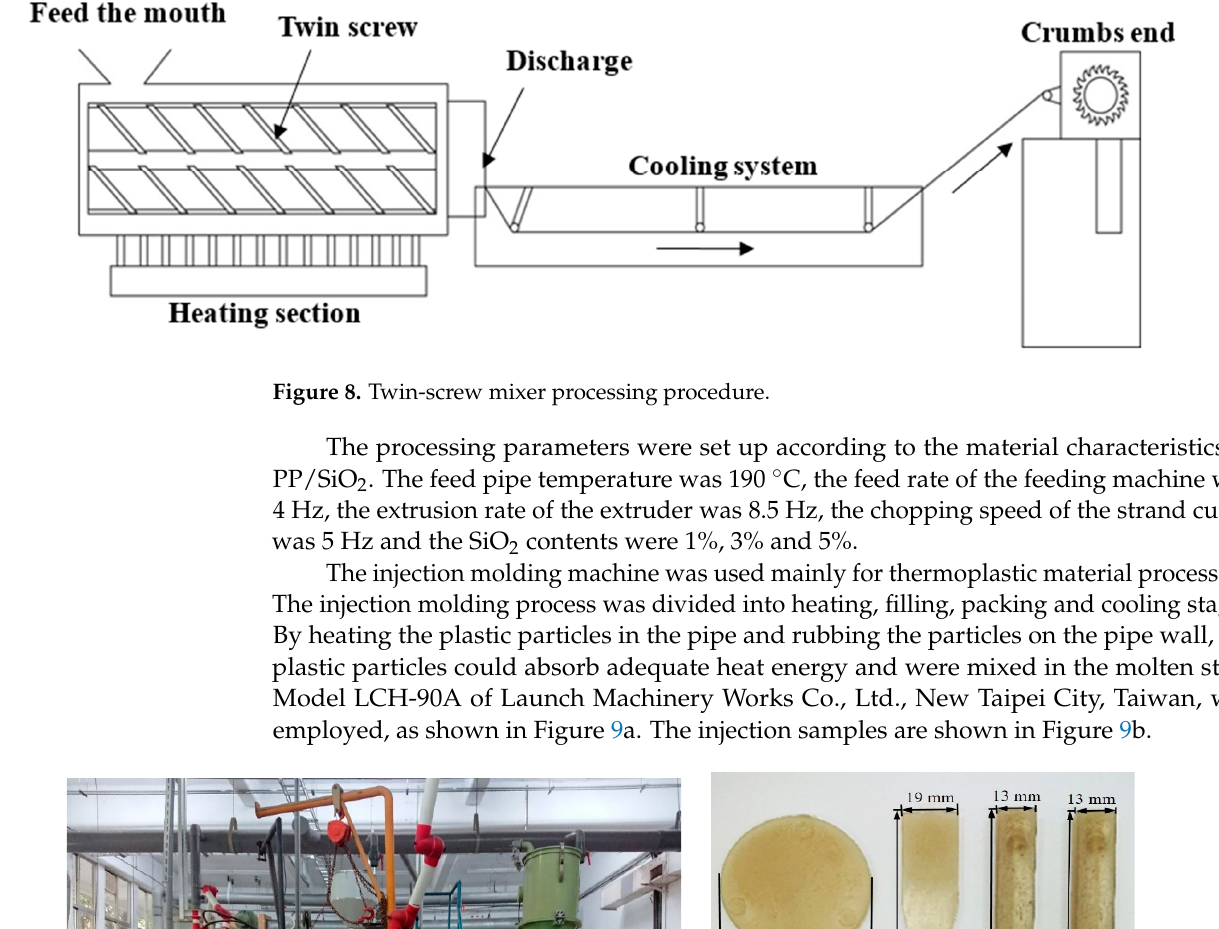
Figure 7. Twin screw mixer: ( a ) Melting and heating zone. ( b ) Water immersion cooling zone. ( c ) Pelletizing and collecting area.